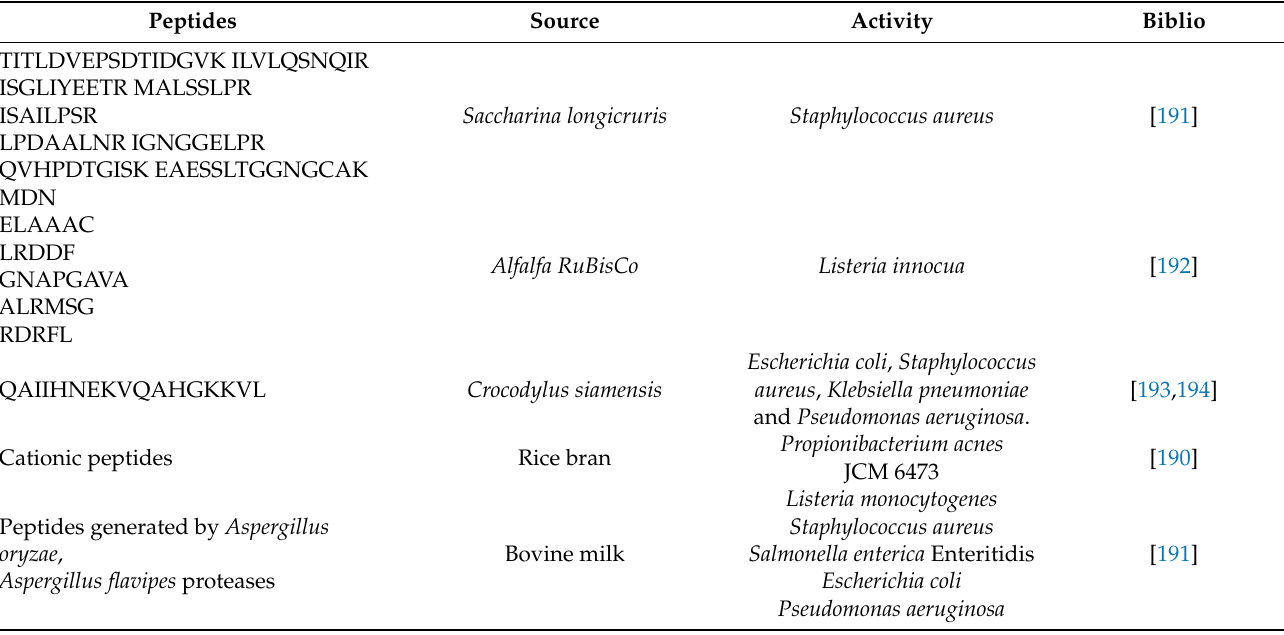
Table 3. Summary of recent studies on antimicrobial